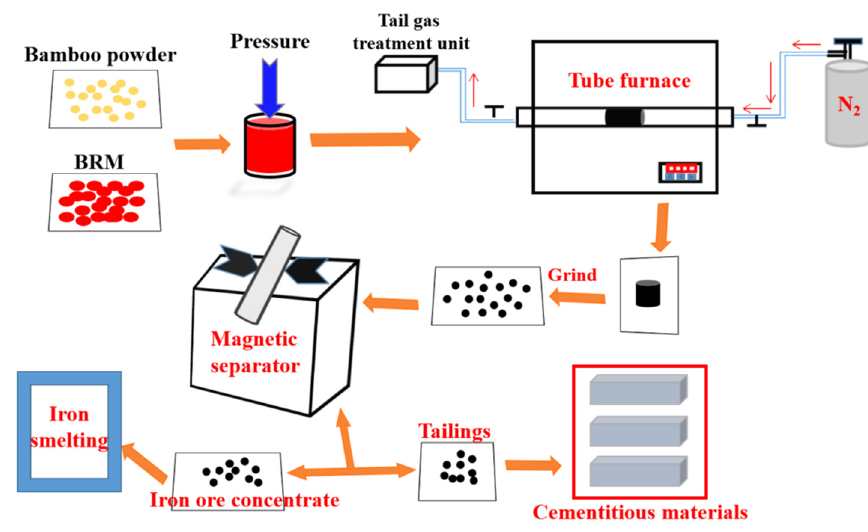
Figure 1. The experimental processes flow.